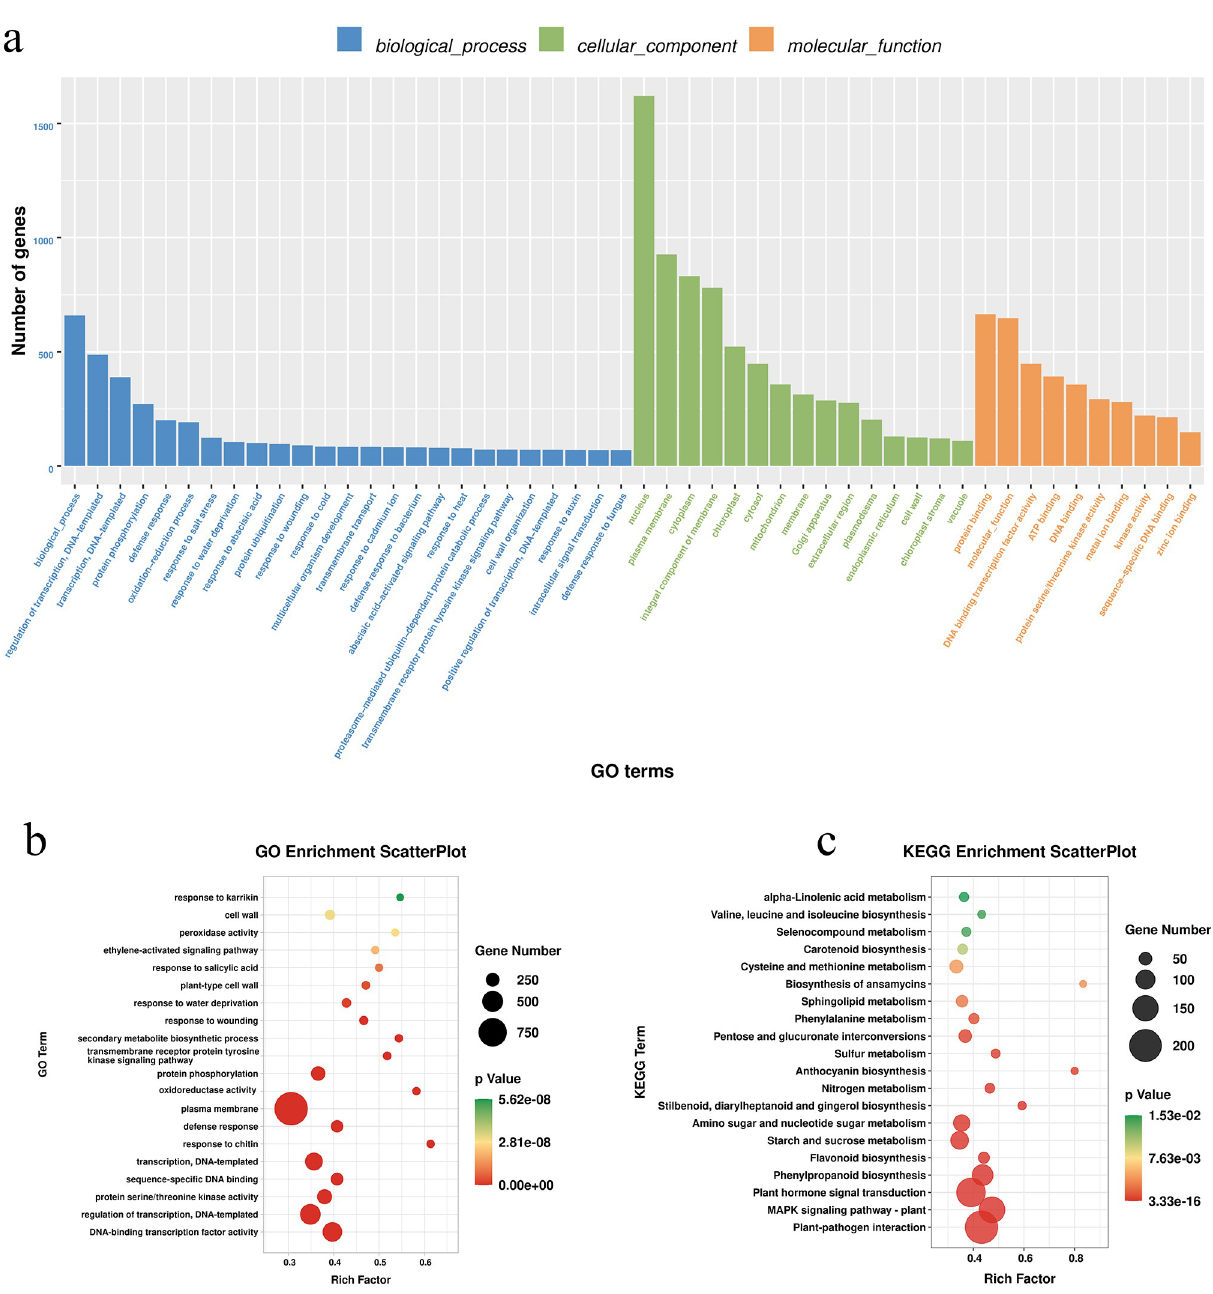
Fig 2. GO and KEGG enrichment analysis of differentially expressed genes. a. Differential gene composition structure based on GO. b. Differential gene GO enrichment items. c. Differential gene KEGG enrichment items.